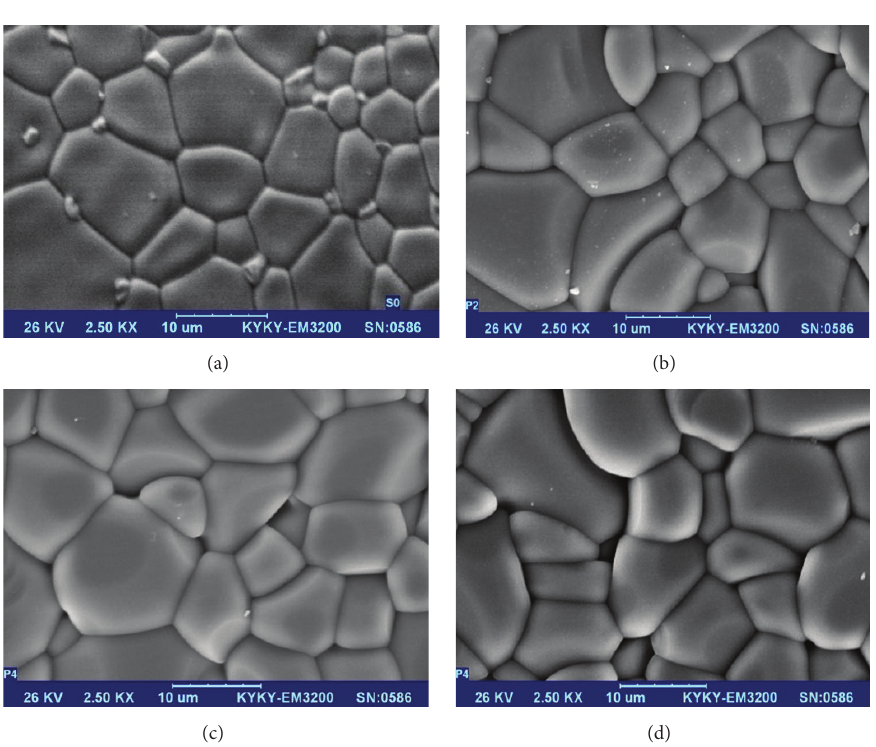
Figure 5: SEM images of brackets irradiated with 0, 100, 200, and 300 mj/s laser